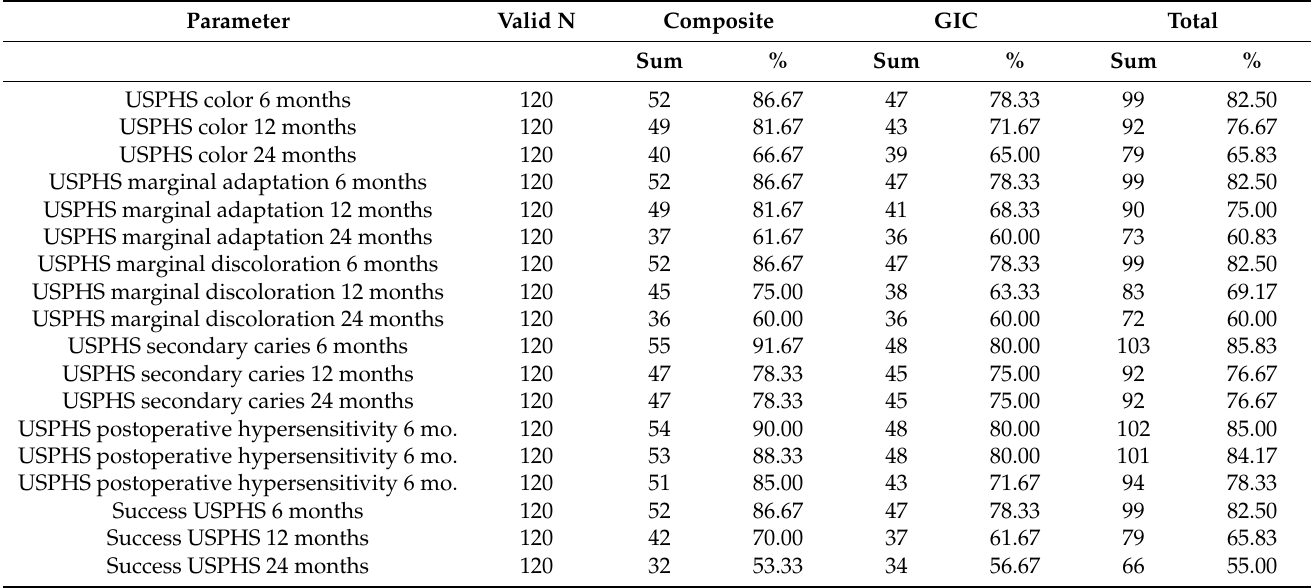
Table 2. Descriptive analysis of USPHS parameters of composites and GICs that had an Alfa